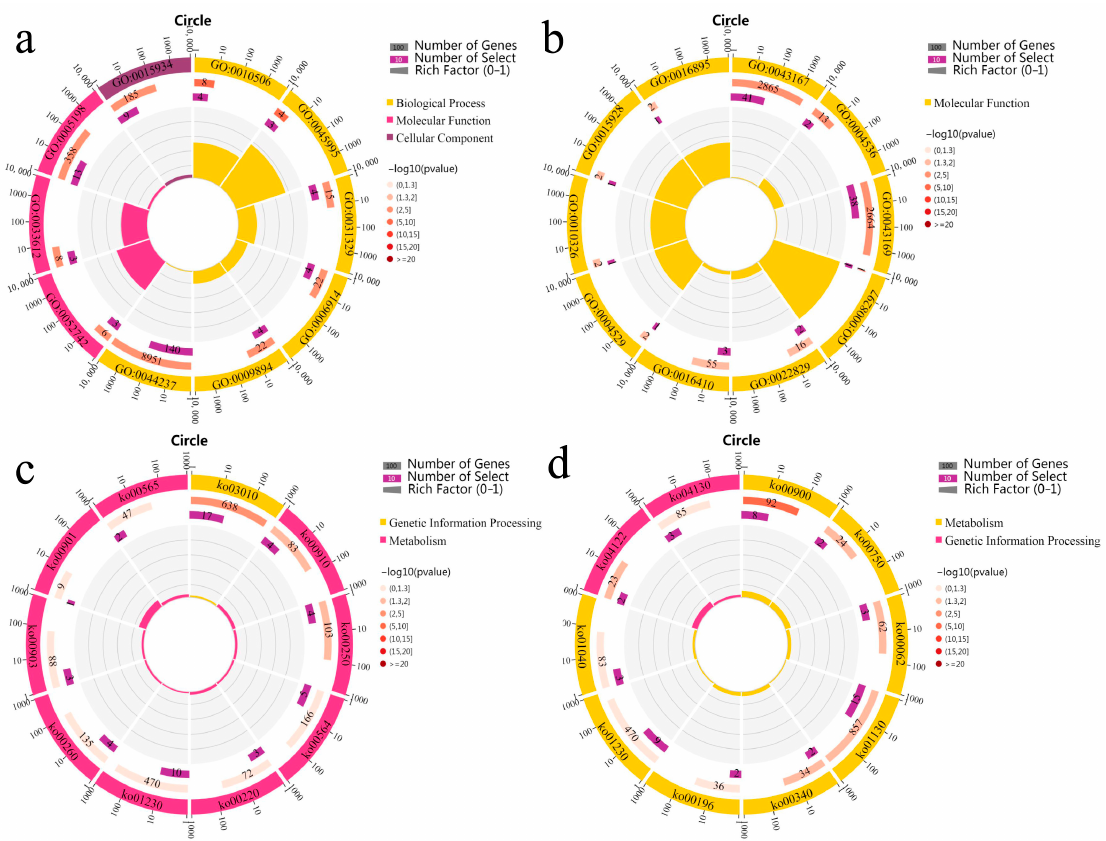
Figure 3. Enrichment analysis of genes correlated to plant growth weight. ( a ) GO enrichment analysis of genes positively correlated to observed value and mid-parent heterosis value of plant growth weight in hybrids. ( b ) GO enrichment analysis of genes negatively correlated to observed value and mid-parent heterosis valueof plant growth weight in hybrids. ( c ) KEGG enrichment analysis of genes positively correlated to observed value and mid-parent heterosis value of plant growth weight in hybrids. ( d ) KEGG enrichment analysis of genes negatively correlated to observed value and mid-parent heterosis value of plant growth weight in